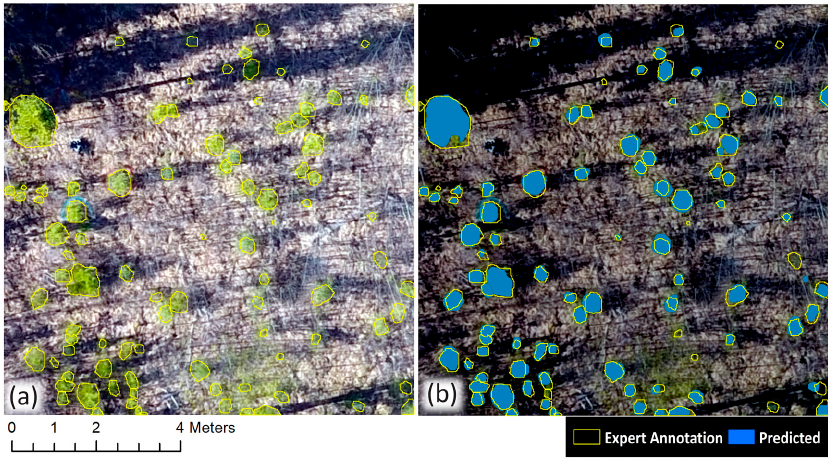
Figure 7. External Validation Tile e (B33). Annotated ground truth ITC are displayed yellow in both panels. The original image is displayed in ( a ). Predicted ITC are displayed in blue ( b ). Remote Sens. 2020 , 12 , x FOR PEER REVIEW